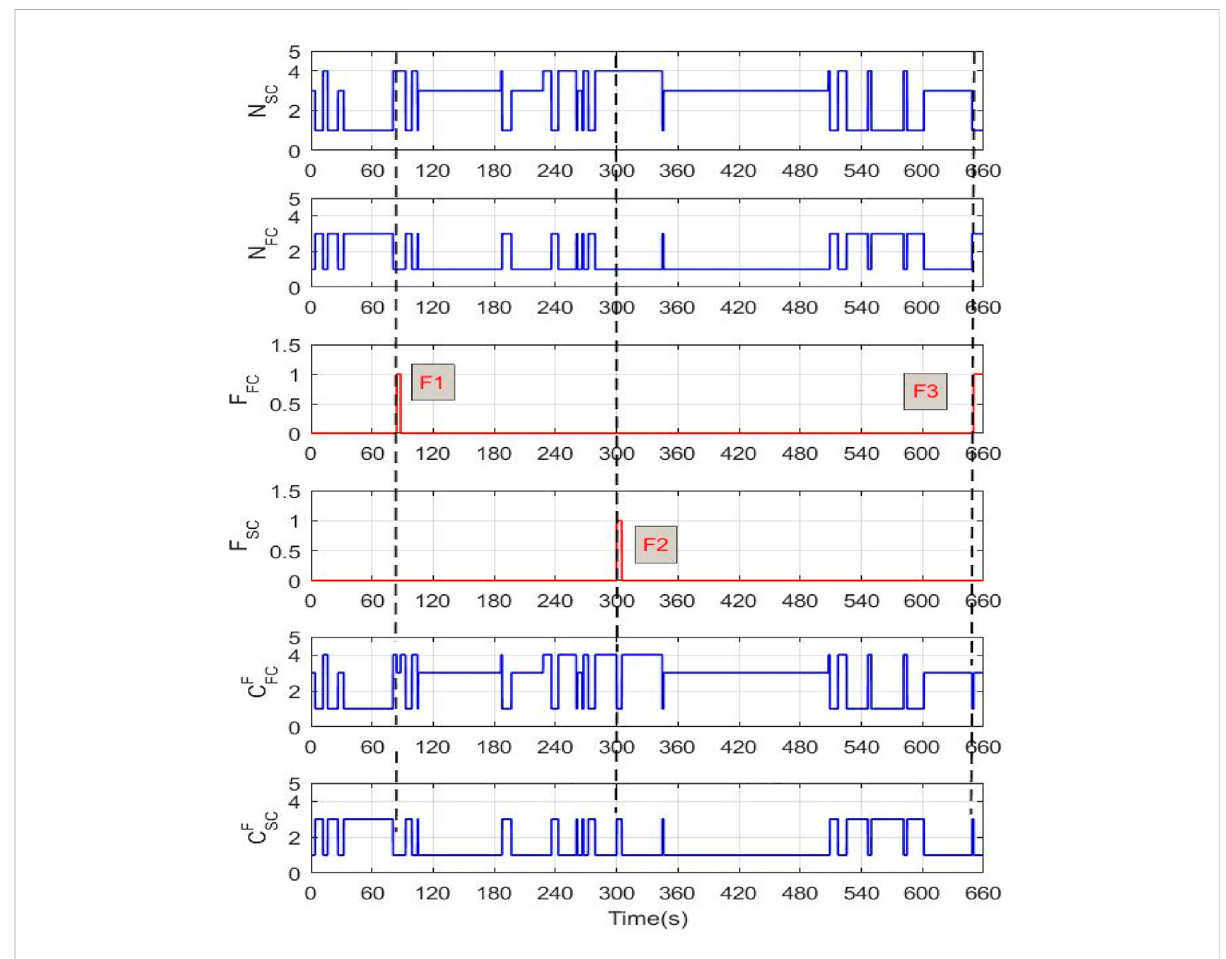
FIGURE 13 Fault and control signals during HEV